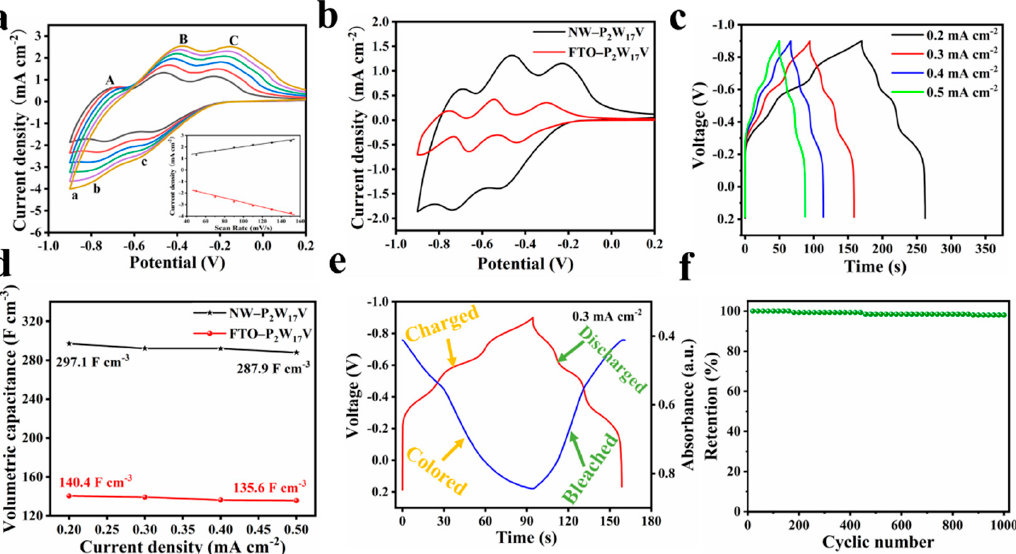
Figure 5. ( a ) CV for the NW − P 2 W 17 V film at different scan rates (from inner to outer): 50, 70, 90, 110, 130, and 150 mV s − 1 . The inset shows plots of the anodic and the cathodic peak currents for C-c against scan rates; ( b ) CV for NW − P 2 W 17 V and FTO − P 2 W 17 V films at a scan rate of 50 mV/s; ( c ) Charge/discharge curves of NW − P 2 W 17 V film at various current densities; ( d ) Volumetric capaci- tance at various current densities of NW − P 2 W 17 V and FTO − P 2 W 17 V films; ( e ) In situ transmittance evolution at 580 nm with the charging and discharging process of the NW − P 2 W 17 V film; ( f ) Cycle performance of NW − P 2 W 17 V film measured under a current density of 0.2 mA cm − 2 .